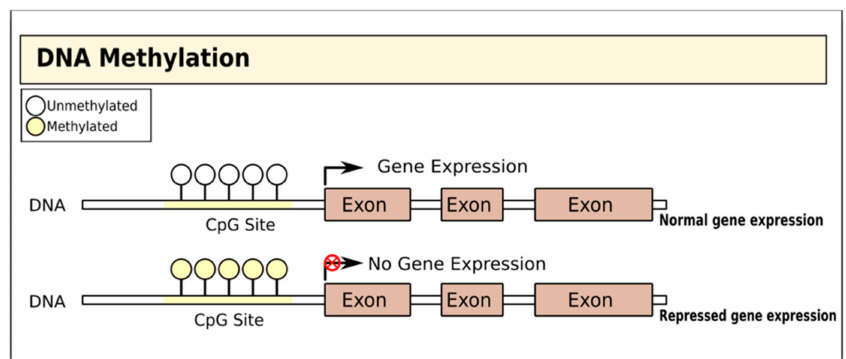
Figure 1. Gene regulation by DNA methylation. DNA is methylated by the covalent addition of a methyl group to CpG dinucleotides by DNA methyltransferases. This process is generally associated with gene